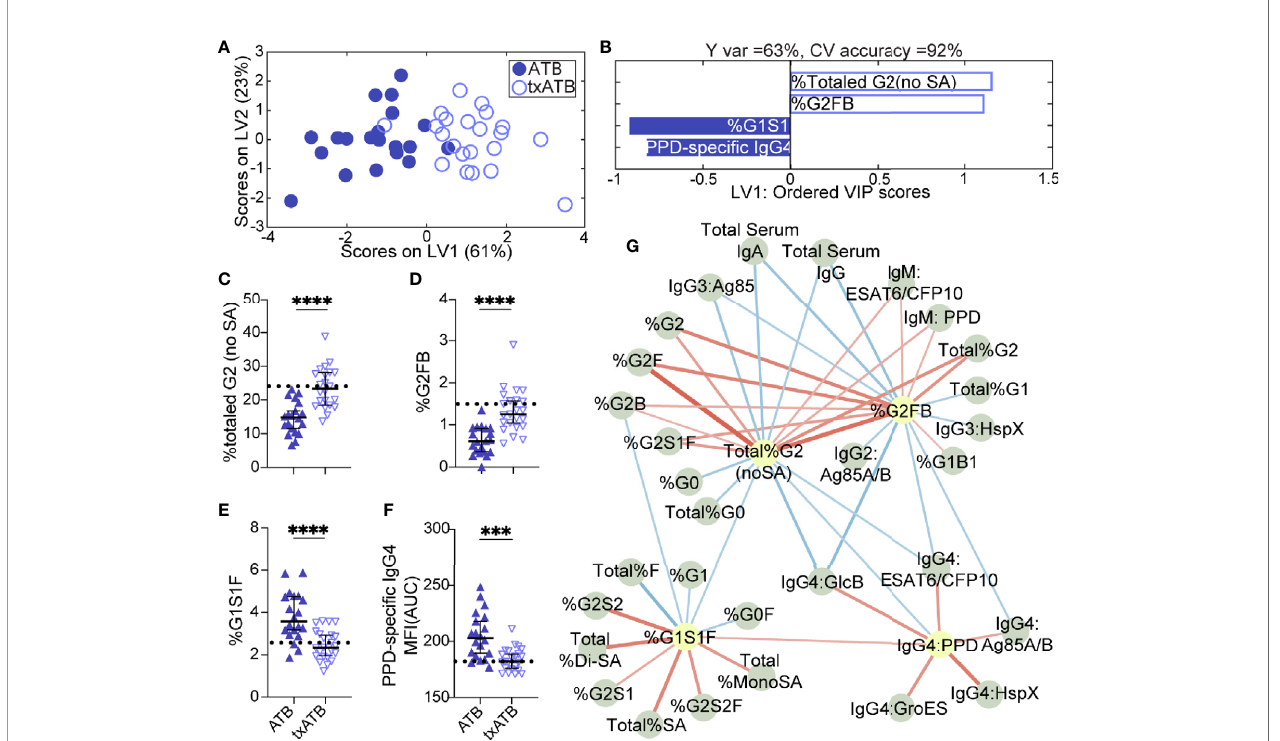
FIGURE 2 | Fc-glycosylation and TB-speci fi c IgG subclass distinguish ATB and txATB individuals. An OPLSDA model was constructed using LASSO-identi fi ed antibody features as input and txATB and ATB group separation as output (A, B). LV1 explains 63% of the Y variance in the direction of the txATB and ATB. 5-fold cross validation resulted in 92% CV accuracy. The model performed signi fi cantly better than models based on shuf fl ed group labels in permutation testing (Wilcoxon p=1E-5). (A) OPLSDA scores plot depicts model separation of ATB (n = 20, blue dots) and txATB (n = 23, periwinkle open dots). LV1 and LV2 account for 61% and 23% of the variability in the input features. (B) VIP scores plot of top features providing the greatest resolution of ATB and txATB in rank-order. Directions of the bars signify loadings on LV1 and colors represent the disease groups in which measures were enriched. Pairwise comparison of ATB (n = 20, blue triangles) and txATB (n = 23, periwinkle open triangles) individuals (C) The frequencies of totaled G2 structures without sialic acid on IgG-Fc of ATB and txATB individuals. (D) percentage of G2FB glycan on IgG (E) percentage of G1S1F glycan on IgG. (F) AUC of PPD-speci fi c IgG4 titers. Univariate plots (C – F) show median and interquartile range of LASSO-selected features and statistically signi fi cant differences between ATB and txATB groups calculated using Mann-Whitney test: ***p < 0.0005, and ****p < 0.0001. The dotted lines represent median of healthy controls (G) Correlation analysis depicts other features that are positively (red lines) or negatively (blue lines) correlated with these four key features selected with LASSO (highlighted in yellow). The color intensity and width of the edges between nodes are proportional to the signi fi cance of correlation coef fi cients after correcting for multiple comparisons (Benjamini-Hochberg q-value < 0.05, testing the hypothesis of zero correlation). Only correlations with corrected p-values < 0.05 were